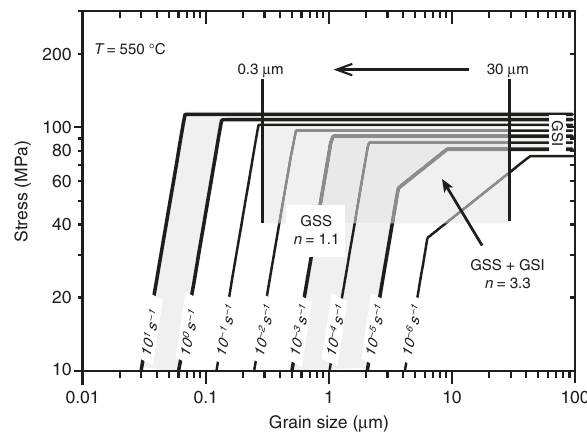
Fig. 4 Deformation map for calcite at 550 °C. Constructed using the creep equations fi tted by ref. 46 (grain size sensitive (GSS), n = 1.1) and ref. 43 (grain size insensitive (GSI) + GSS, n = 3.3) on data from axi-symmetric compression tests on synthetic calcite aggregates, and using an exponential-type, GSI creep equation fi tted to data from triaxial compression test on Carrara marble by ref. 44 . Strain rate contours are shown for _ ε = 10 − 6 to 10 1 s − 1 . The shaded area plots the conditions relevant to our experiments, based on estimates from grain size and equivalent compressive